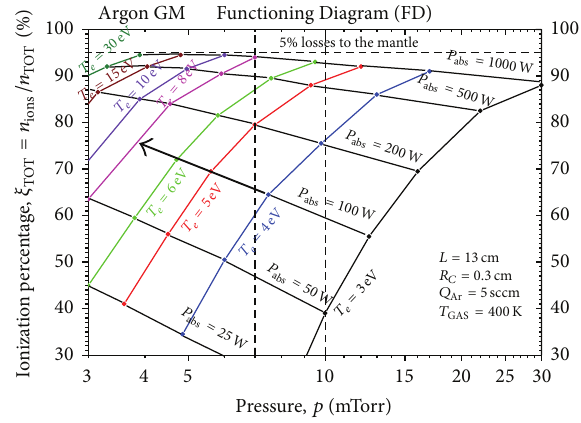
Figure 13: “Functioning Diagram” (FD) for the feeding of 5sccm, for the “core” region of the N 2 O fed HPT.